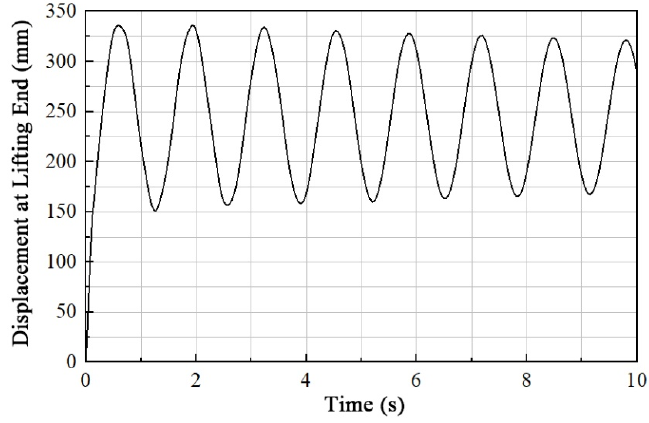
Figure 14. Displacement Response of the Lifting Arm at the Lifting End in the Third Stage.